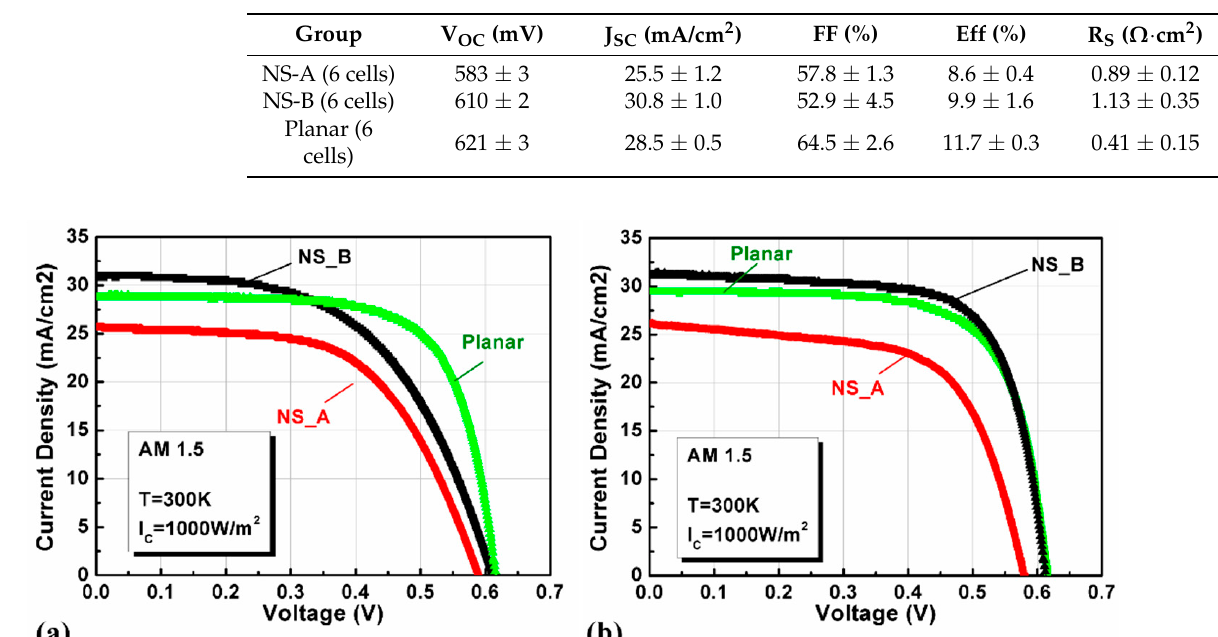
Figure 6. ( a ) I–V curves of the sample solar cells under standard test condition (AM 1.5 irradiation, T = 300 K, and P = 1 kW/m 2 ) before light-induced plating. ( b ) I–V curves of the cells after the light-induced plating. It can be observed that the FF and J SC were improved after the enhancement.